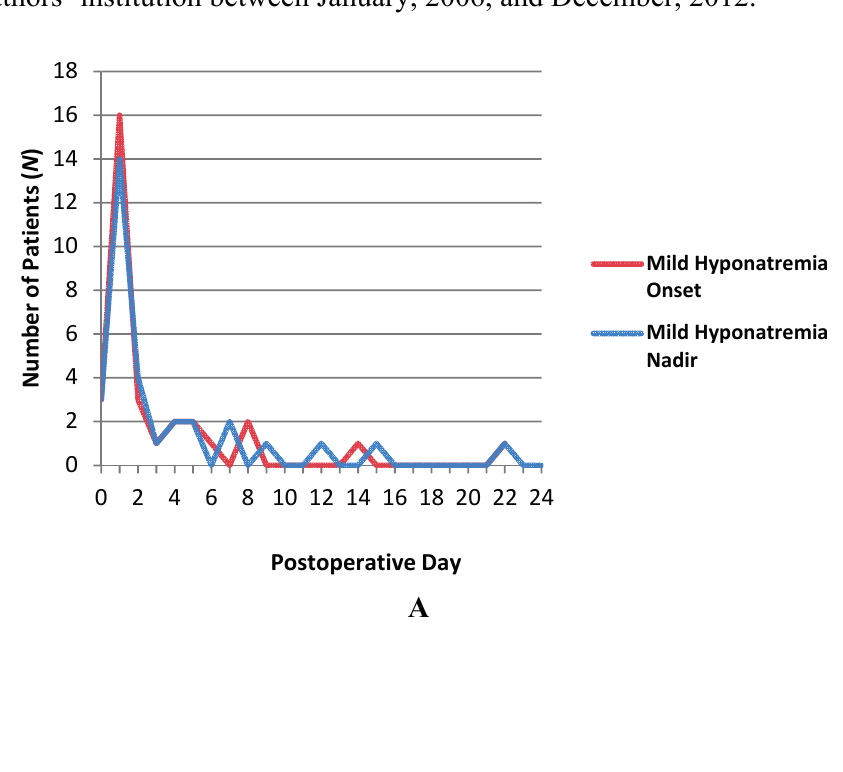
Figure 1. Line graphs illustrating the day of hyponatremia onset (the first documented serum sodium <135 mEq/L) and nadir in each of the three severity groups ( A : mild; B : moderate; C : severe hyponatremia) in 62 patients with post-operative hyponatremia in a group of 344 consecutive patients who underwent transsphenoidal resection of a